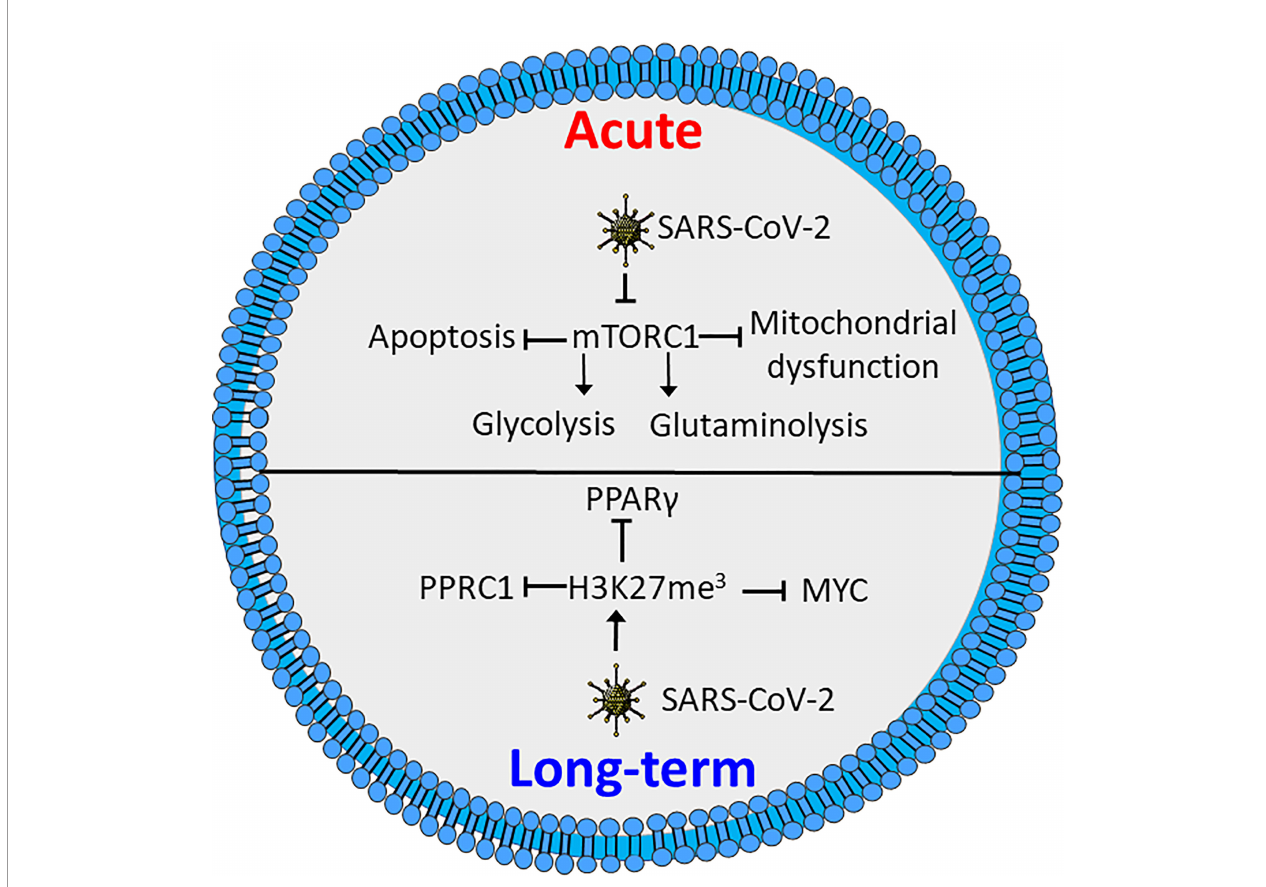
FIGURE 3 | SARS-CoV-2 induces metabolic defects in acute and long-term infection. Acute infection by SARS-CoV-2 inhibits activation of mTORC1, causing reduced glycolysis and glutaminolysis as well as enhanced apoptosis and mitochondrial defects. Long-term SARS-CoV-2 induces triple methylation of histone 3 lysine 27 (H3K27me 3 ), resulting in reduced activation through inhibition of MYC peroxisome proliferator-activated receptor g (PPAR g ) and peroxisome proliferator- activated receptor gamma coactivator-related protein 1 (PPRC1). Figure was created using assets from Servier Medical Art, licensed under a Creative Common Attribution 3.0 Generic License.